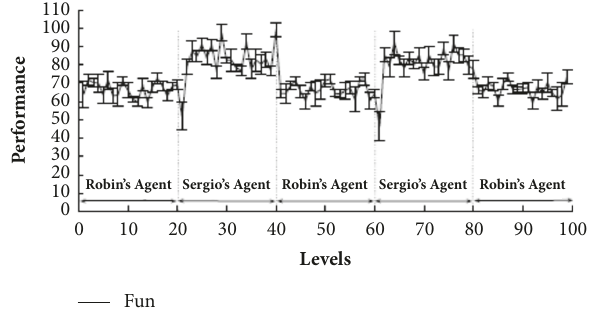
Figure 4: Two-agent optimized levels of fun.